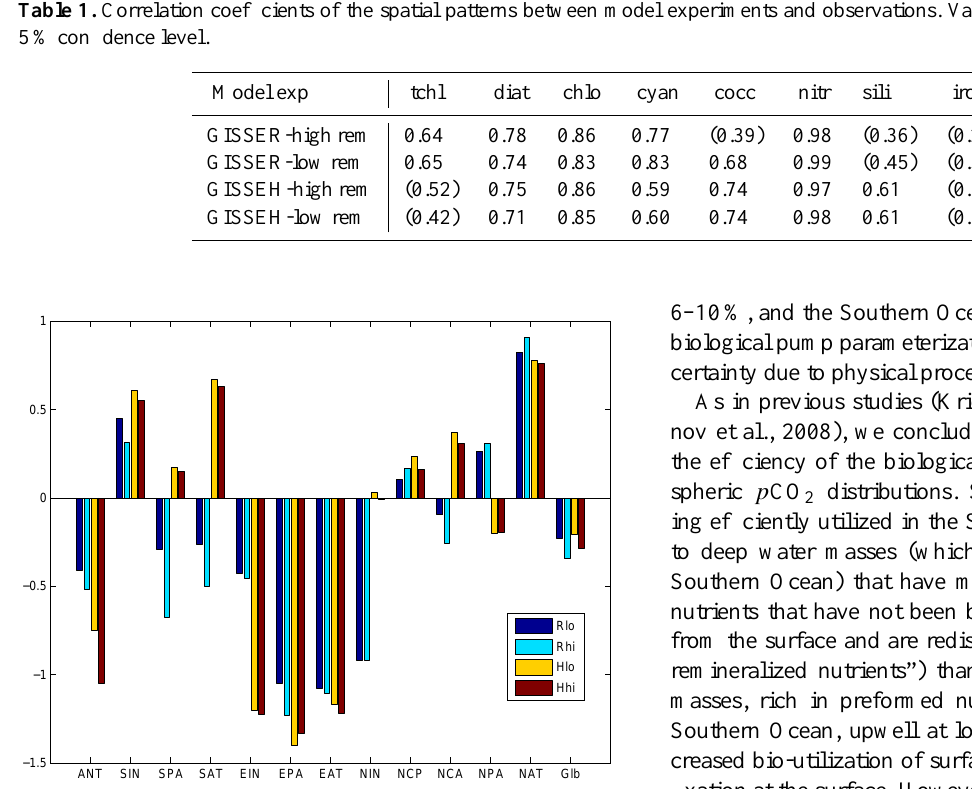
Fig. 14. Regional fluxes (in mmol C m − 2 yr − 1 ). The values are scaled to take into account the different areas of the regions. ANT: around Antarctica, SIN: Southern Indian Ocean, SPA: Southern Pacific Ocean, SAT: Southern Atlantic Ocean, EIN: Equatorial Indian Ocean, EPA: Eastern Pacific, EAT: Eastern Atlantic, NIN: Norhtern Indian, NCP: North-Central Pacific, NCA: North-Central Atlantic, NPA: North Pacific, NAT: North Atlantic and Glb: global ocean.